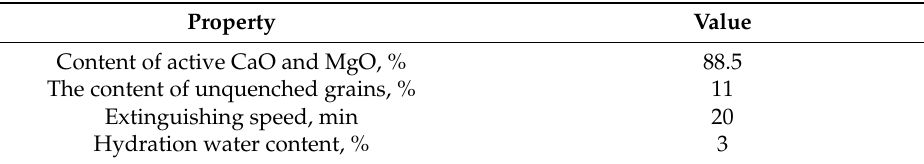
Table 7. Characteristics of